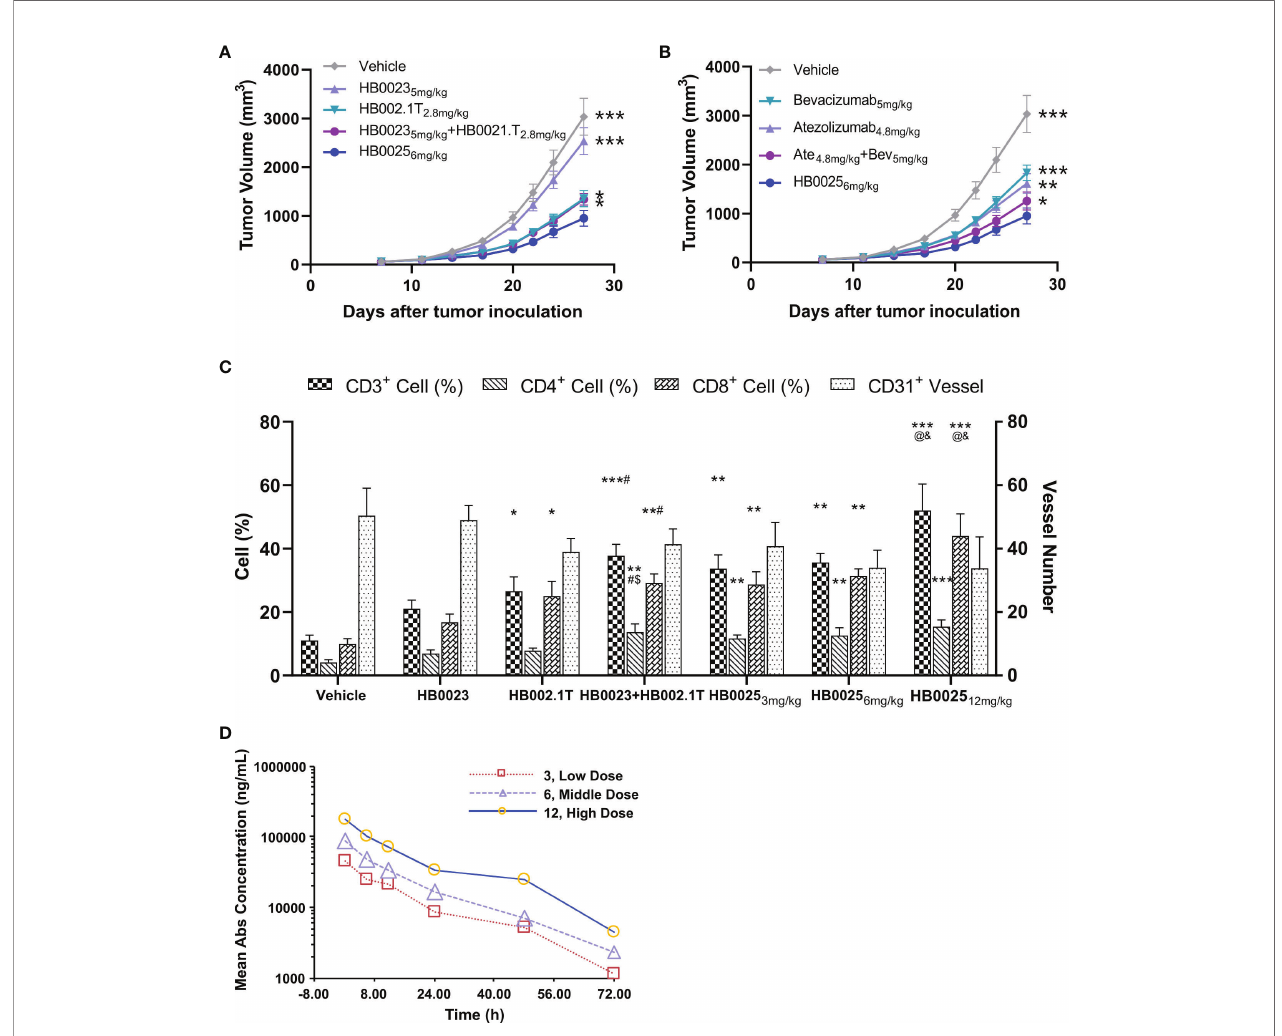
FIGURE 3 | Pharmacodynamics and pharmacokinetic analysis in NCG mice. (A) HB0025 treatment compared with HB0023, HB002.1T, and HB0023+HB002.1T in NCG mice. (B) HB0025 treatment compared with bevacizumab, atezolizumab, and bevacizumab+atezolizumab in NCG mice. *p < 0.05, **p < 0.01, ***p < 0.001 compared with HB0025 6mg/kg. (C) Tumor-in fi ltrating lymphocytes (CD3 + , CD4 + , CD8 + ) and the numbers of blood vessels (CD31 + ). *p < 0.05, **p < 0.01, ***p < 0.001 compared with the vehicle; # p < 0.05 compared HB0023 with HB0023+HB002.1T; $ p < 0.05 compared HB002.1T with HB0023+HB002.1T; @ p < 0.05 compared with HB0025 (3 mg/kg)/HB0025 (6 mg/kg) with HB0025 (12 mg/kg); and p < 0.05 compared HB002.1T+HB0023 with HB0025 (12 mg/kg). (D) The pharmacokinetic pro fi les of HB0025 in NCG mice at doses 3, 6, and 12 mg/kg. data expressed as mean ±